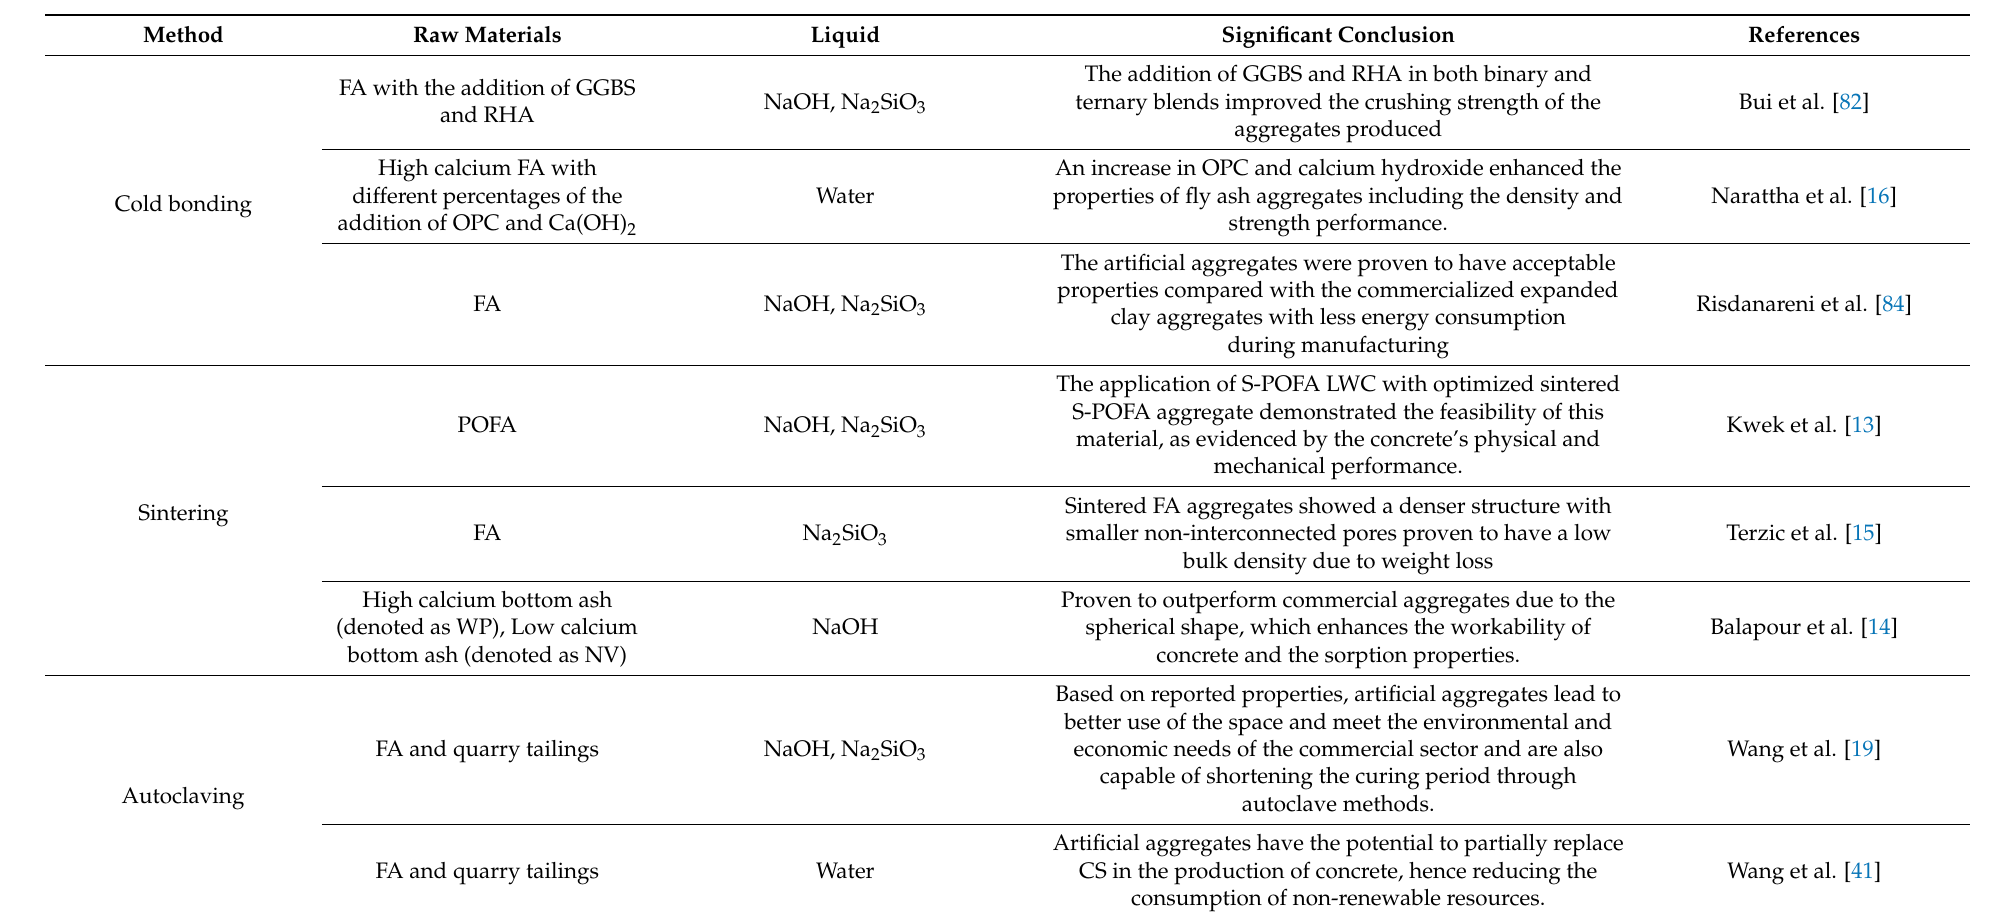
Table 3. Findings on the utilization of cold bonding, sintering, and autoclaving as curing methods for geopolymer-based artificial